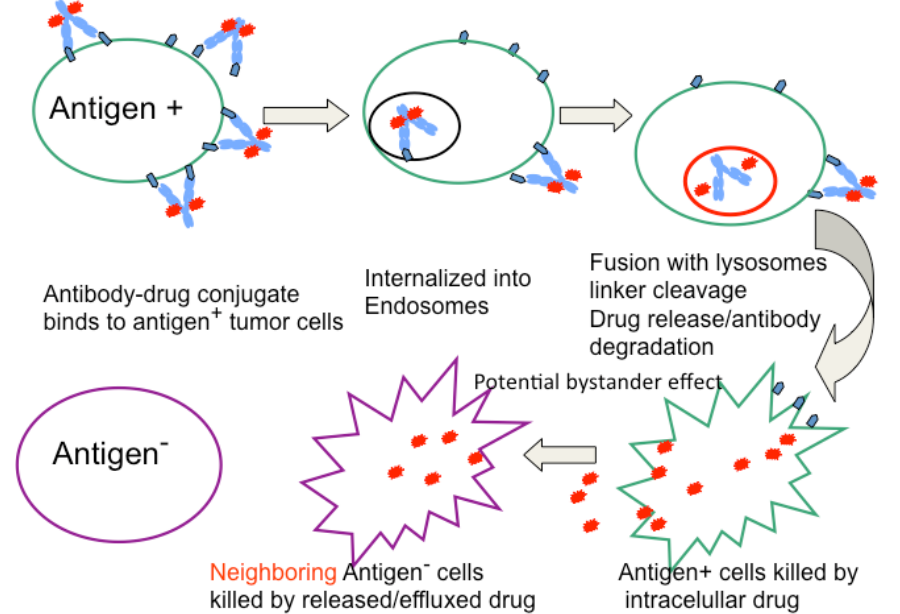
Figure 2. Mechanism of ADC activity. Following tumor localization, ADCs bind to antigen expressing cells, is internalized into endosomes/lysosomes where biologically active drug is released following enzymatic cleavage or MAb catabolism. The liberated drug enters the cytoplasm where it binds to its molecular target (typically DNA or tubulin) resulting in cell cycle arrest and apoptosis. The drug may also diffuse out of or be released from dying cells and if membrane permeable can enter cells (antigen positive or negative) in close proximity and mediate bystander